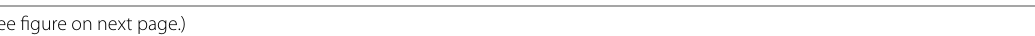
figure on next Fig. 2 Sentence intelligibility in young and older adults. Note. a Young and older adults’ keyword intelligibility for each mask type by noise level. Black dots indicate the mean accuracy in each condition, and colored dots indicate means for individual participants. b Line graphs showing keyword intelligibility by noise level for each mask type in young and older adults. Error bars indicate panel conveys the same information as the top panel but more clearly displays how noise affects intelligibility across mask